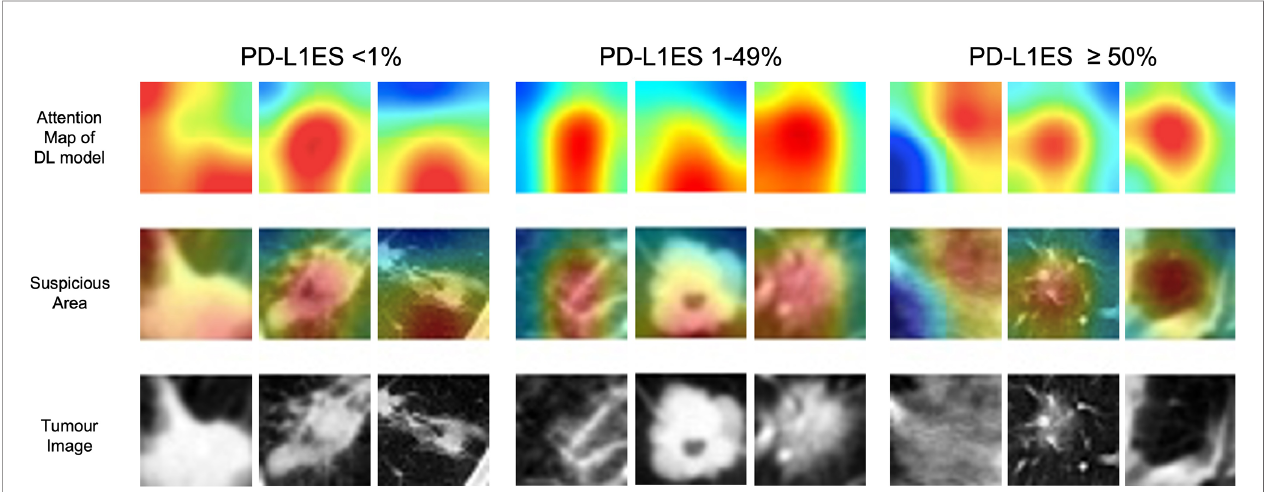
FIGURE 3 | The illustration of deep learning feature heatmap to predict PD-L1 expression. The fi rst and second rows visualize the attention regions of a network for distinct mutant categories; the third row shows the origin tumor image in the 3D volume. PD-L1ES, PD-L1 expression signature.